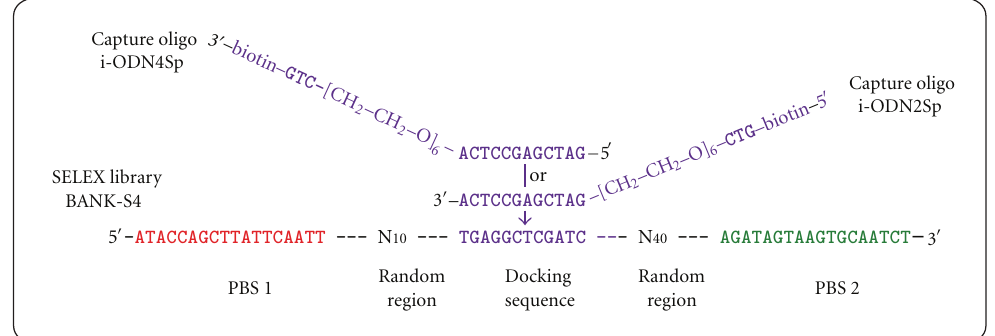
Figure 1: Specific composition of the Capture-SELEX library BANK-S4 and the capture oligos i-ODN2Sp and i-ODN4Sp. PBS 1 and PBS 2 represent the primer binding sites of each oligonucleotide in the